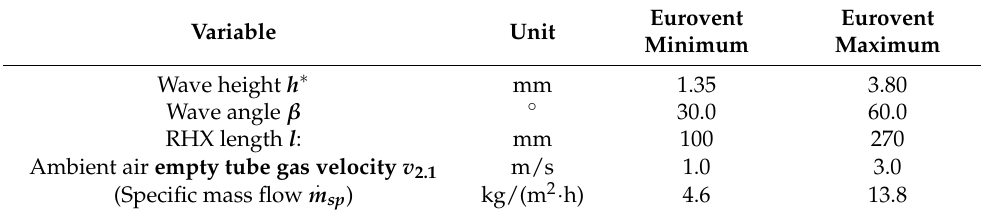
Table 3. Eurovent database minimum and maximum reported